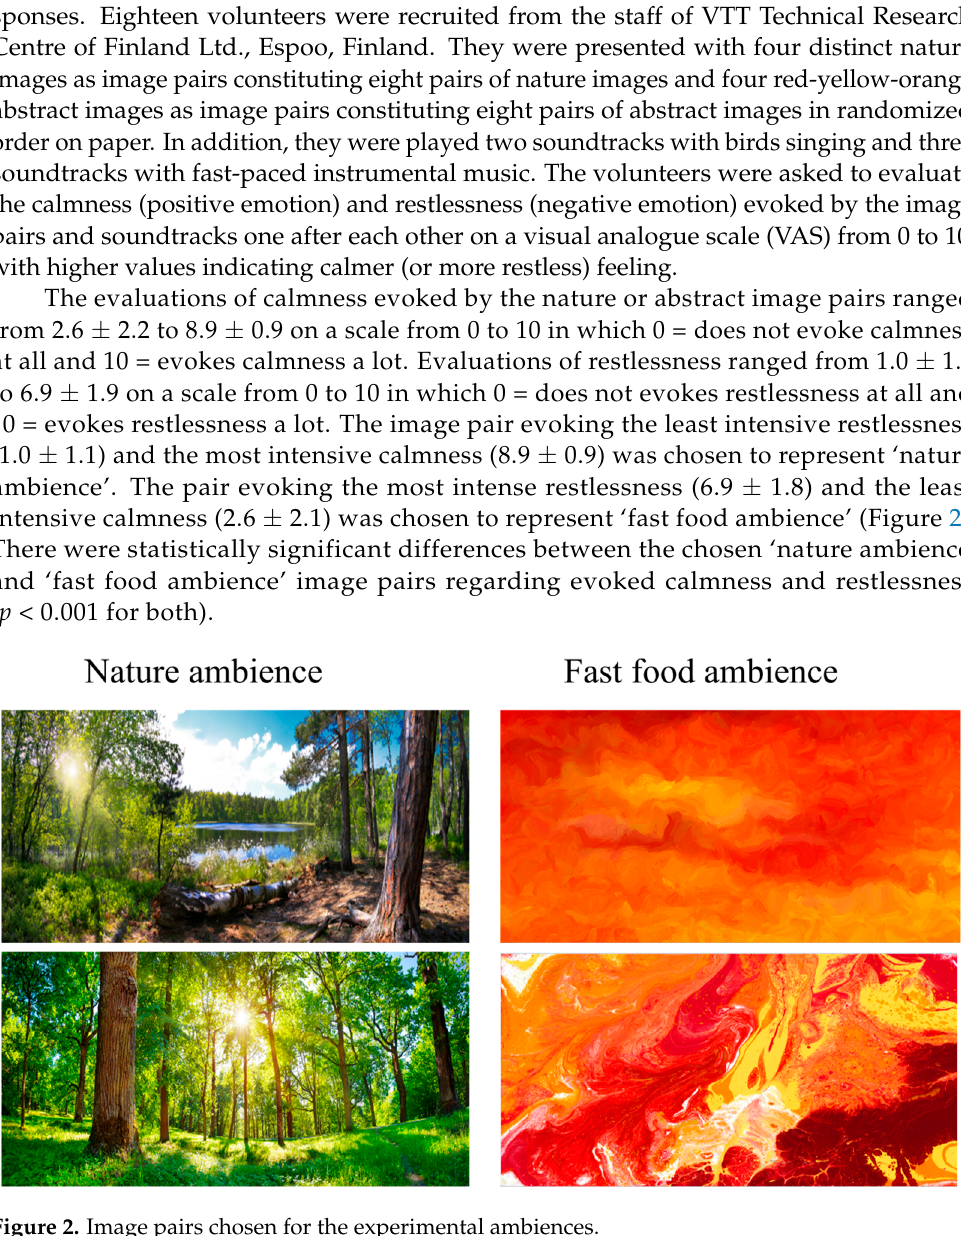
= does not evoke calmness at all and 10 = evokes calmness a lot and 1.5 ± 1.8 in restlessness.